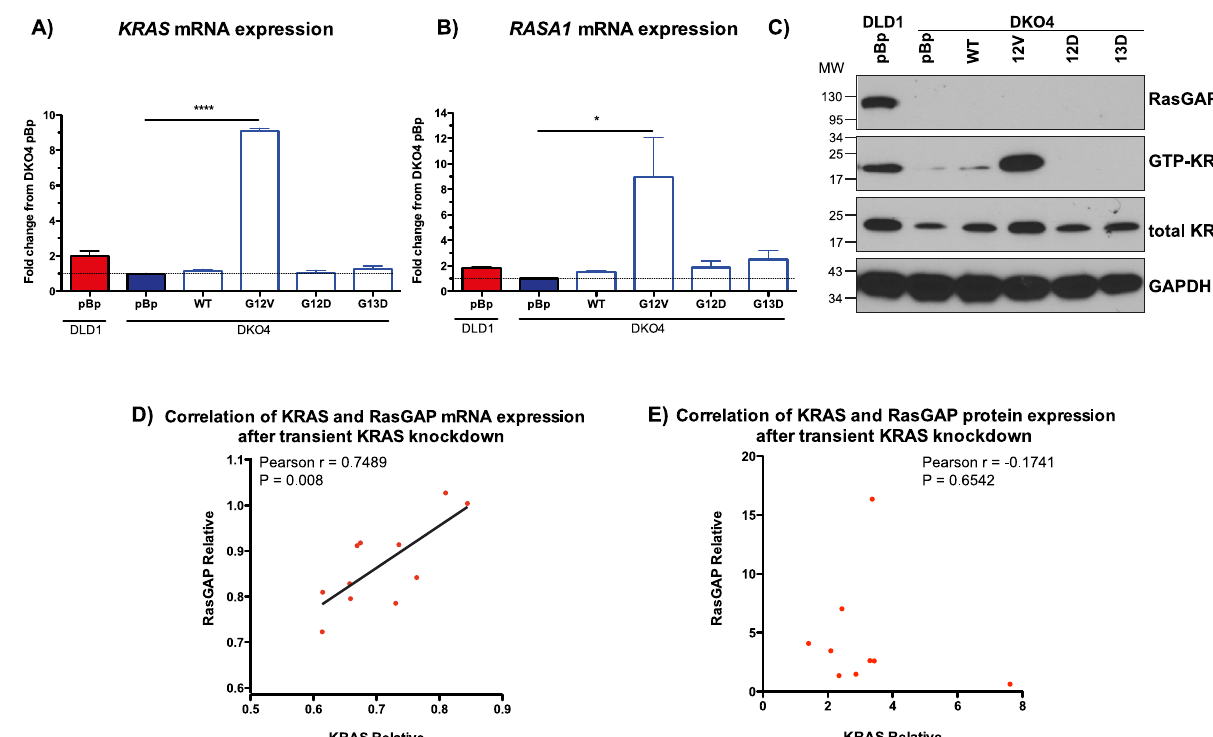
Figure 3. RasGAP expression is mediated in part by KRAS. Wild-type (WT) or mutant KRAS was overexpressed in DKO4 cells. mRNA was extracted from cells and quantified using rt-qPCR to measure KRAS (A) or RASA1 (B). C) Western blotting showing levels of these proteins, along with activation status of KRAS. Correlation of mRNA (D) and protein expression using densitometry analysis of Western blotting (E) of KRAS and RASA1 after knockdown of KRAS using 11 different shRNAs. For protein correlation, outliers over 3 standard deviations from the mean were excluded. All quantification is relative to empty vector. Statistical analysis of expression using unpaired t-test, ***p , 0.001, *p , 0.05.